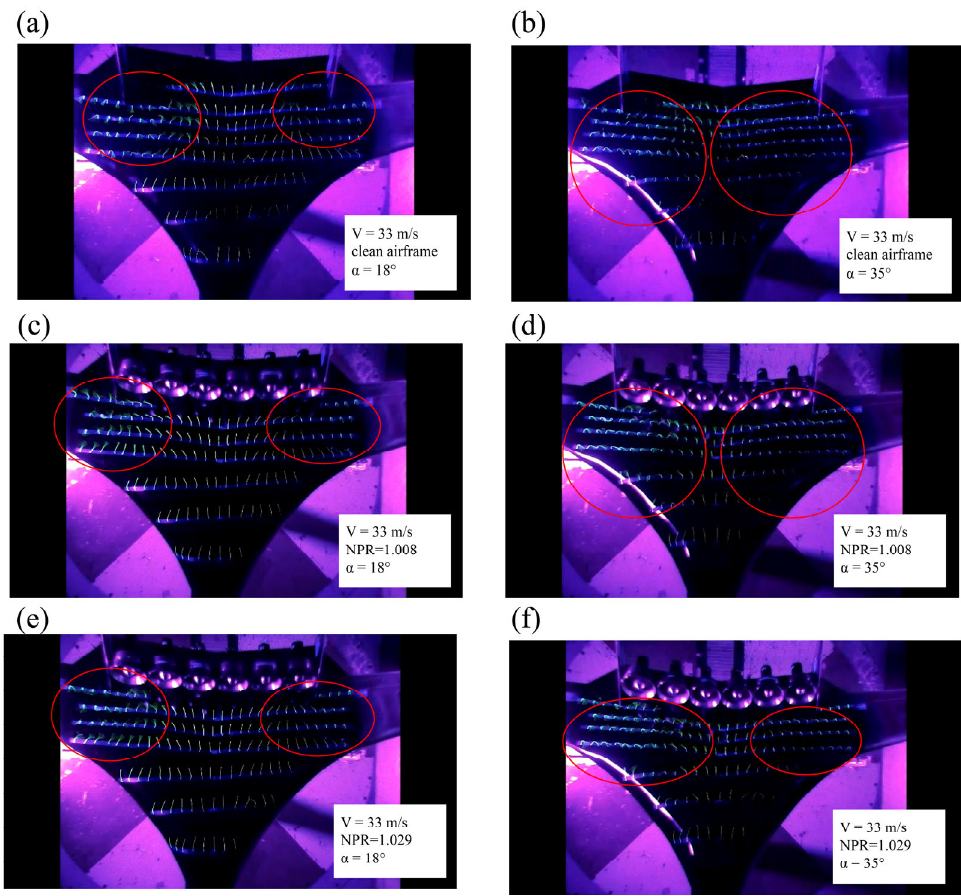
Figure 14. Fluorescent minituft pictures of the wind tunnel experiments. ( a ) “clean airframe” at α = 18 ◦ ; ( b ) “clean airframe” at α = 35 ◦ ; ( c ) NPR = 1.008 at α = 18 ◦ ; ( d ) NPR = 1.008 at α = 35 ◦ ; ( e ) NPR = 1.029 at α = 18 ◦ ; ( f ) NPR = 1.029 at α = 35 ◦